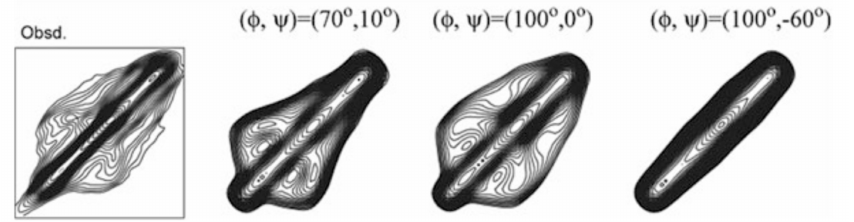
Figure 6. 2D spin-diffusion NMR spectrum of (AG) 6 A[1- 13 C]G 14 A 15 [1- 13 C]G 16 (AG) 7 . The torsion angles of Ala 15 residue were set as ( φ , ψ ) = ( − 60 ◦ , 120 ◦ ), and therefore, the spectral pattern depends on the torsion angles, ( φ , ψ ) of Gly 16 . The calculated spectra for three torsion angles, ( φ , ψ ) = (70 ◦ , 10 ◦ ), (100 ◦ , 0 ◦ ) and (100 ◦ , − 60 ◦ ) selected from Figure 5 are shown [22]. Reprinted with permission from ref. 22.